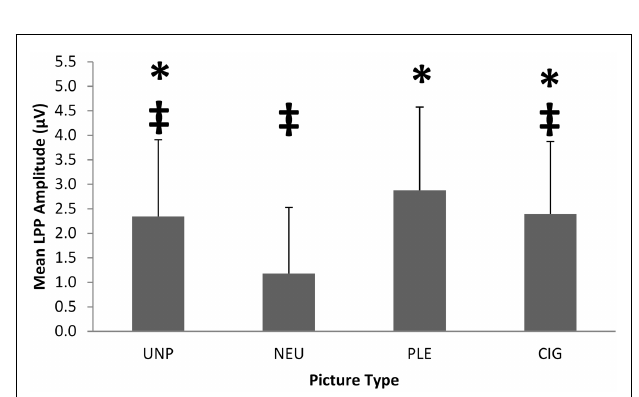
FIGURE 1 |The significant picture category (UNP, NEU, PLE, CIG) main effect on mean LPP amplitude for 104 smokers of European ancestry . The error bars depict standard deviations. *Significantly different from NEU. ‡ Significantly different from PLE.